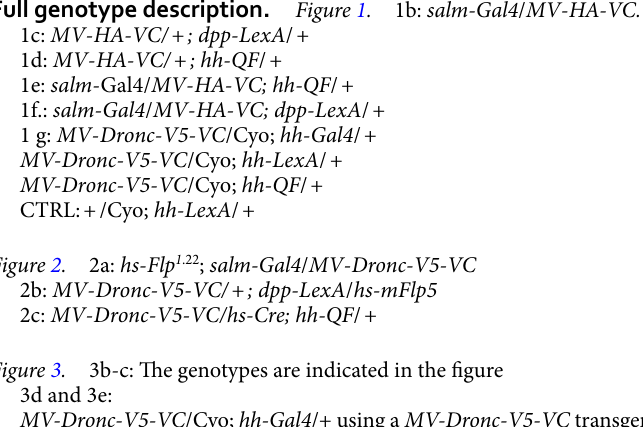
Figure 3. 3b-c: The genotypes are indicated in the figure 3d and 3e: MV-Dronc-V5-VC /Cyo; hh-Gal4 /+ using a MV-Dronc-V5-VC transgene with (+ QUAS ) or without (- QUAS ) repeats. The QUAS repeats were permanently removed in the germline following the protocol described in Figure 3. Supplementary Fig. 1. 1b: salm-Gal4 / MV - HA-VC; hh-QF / + 1d: salm-Gal4 / MV - Dronc-V5-VC; dpp-LexA / + 1e: salm-Gal4 / MV - Dronc-V5-VC; hh-QF / + Supplementary Fig. 2. 2a: Genotypes are the same than in the Fig. 1g. 2b and 2e: MV- Dronc-V5-VC /Cyo; hh-Gal4 / + MV- Dronc-V5-VC /Cyo; hh-LexA / +